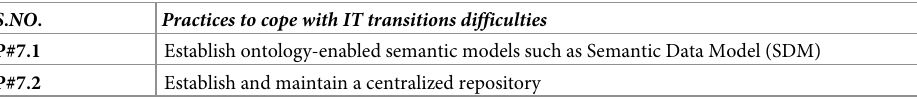
Table 10. Practices to cope with IT transitions difficulties in COR.